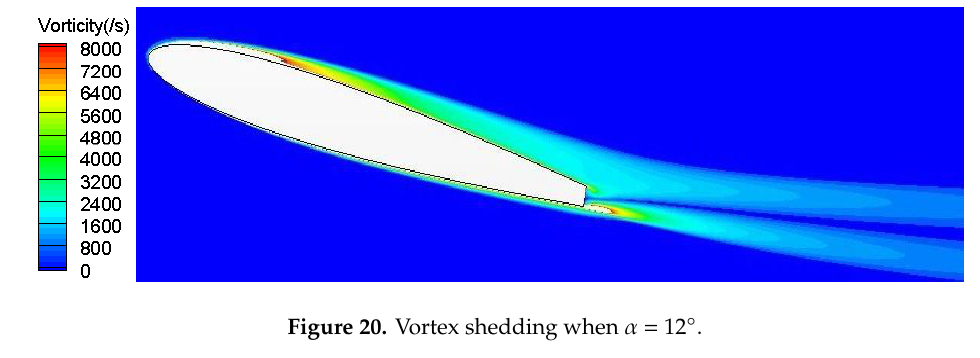
Figure 20. Vortex shedding when α = 12°.